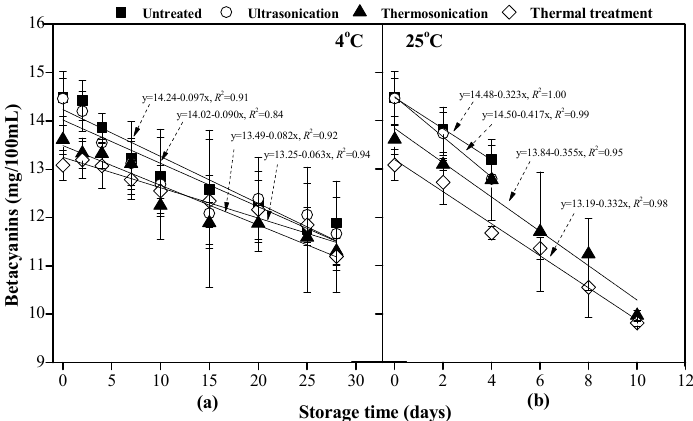
Figure 5. Change of the contents of betacyanins in red pitaya juices during storage at 4 °C ( a ) and 25 °C ( b ), as subjected to thermosonication (475 W, 56 °C, 20 min), ultrasonication (475 W, 10 °C, 20 min), and thermal (83 °C, 1.5 min) treatments. Dotted lines are fitting curves with the linear model.